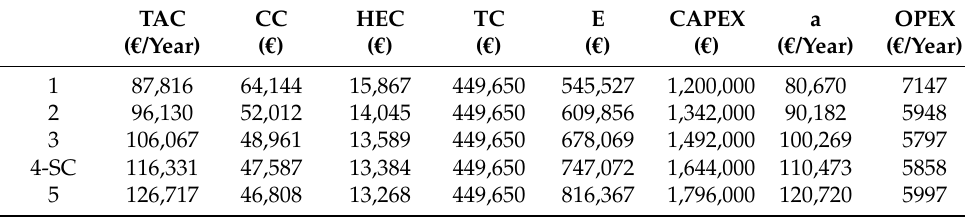
Table 6. Summary of costs per scenario considering a storage pressure of 20 bar, H 2